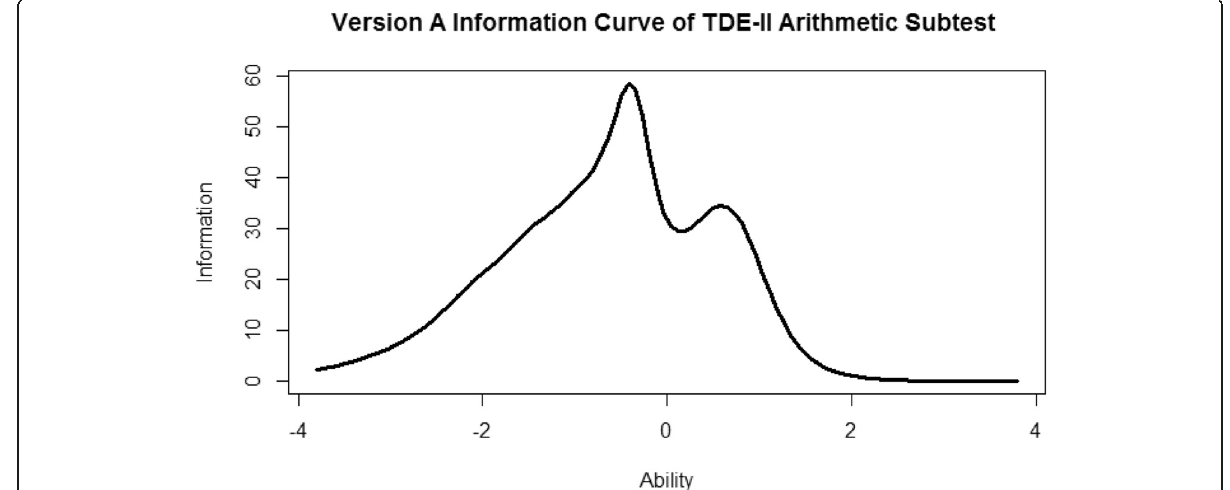
Fig. 1 Version A test information curve of the TDE-II Arithmetic